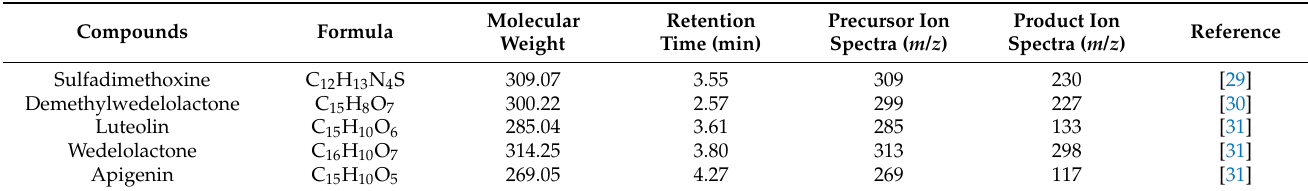
Figure 6. Chemical structure of demethylwedelolactone, luteolin, wedelolactone, apigenin and sulfadimethoxine. Table 1. Chemical standards detected by UPLC/MS/MS analysis.